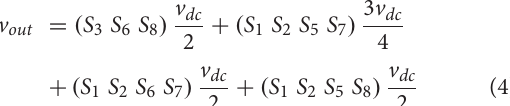
FIGURE 1 | Topology proposed in Sajadian and Santos